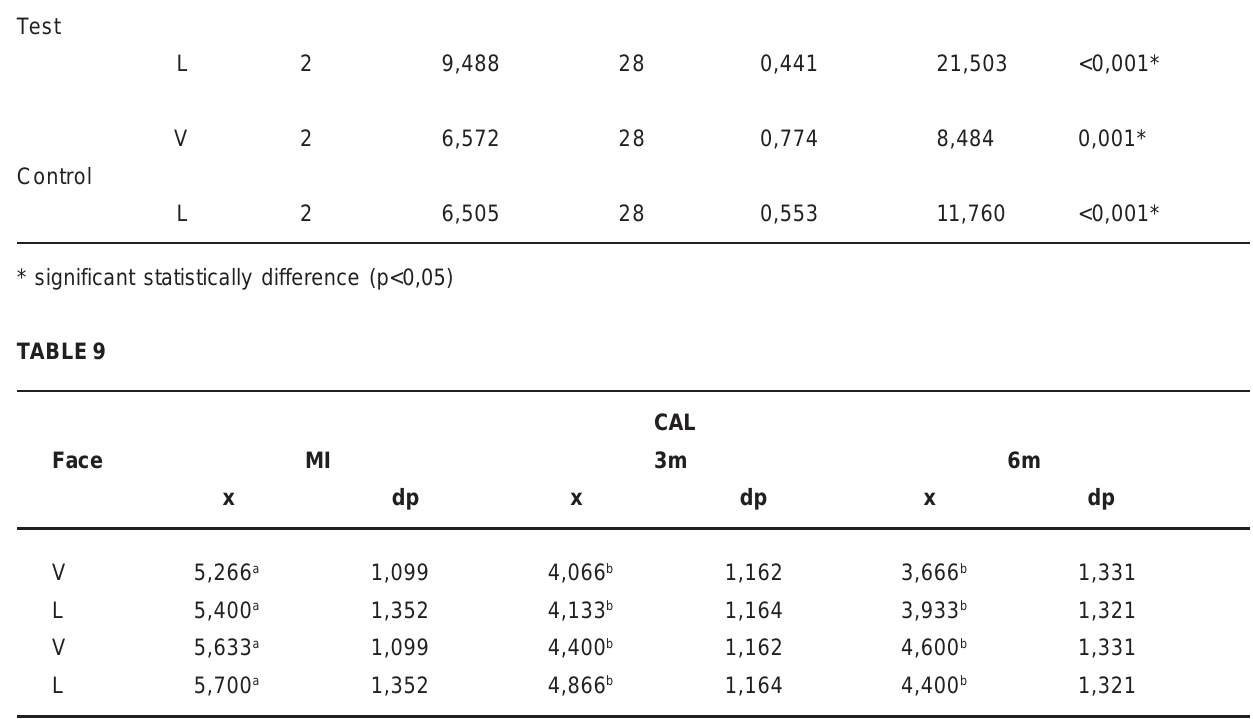
Same letter- No significant